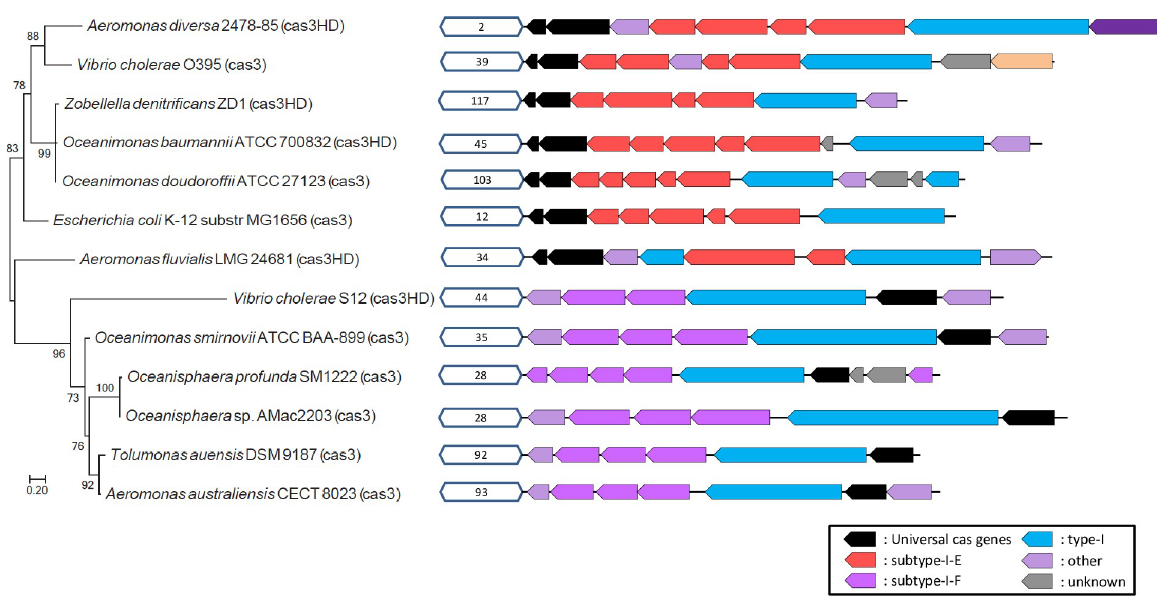
Fig 9. Phylogenetic trees built from the cas3/cas3HD genes of the clustered regularly interspaced short palindromic repeat (CRISPR)-Cas systems. Different colors indicate different types of CRISPR genes, and white hexagons in front of the CRISPR-Cas genes contain the numbers of repeats (i.e., the number of spacers) identified from the CRISPR